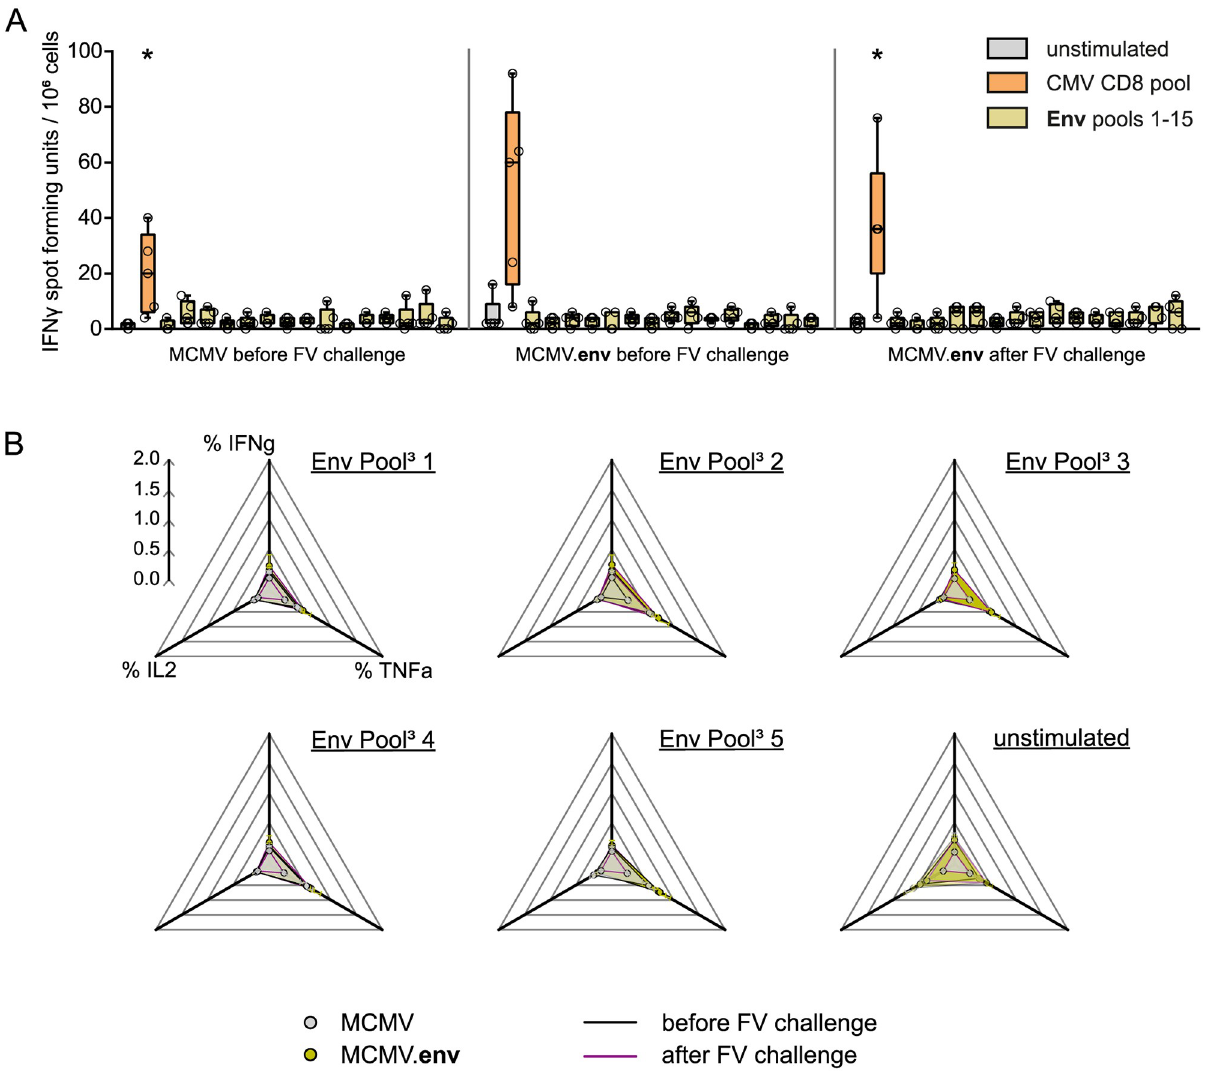
Fig 8. Analysis of Env-reactive T cells. CB6F1 mice were immunized once with MCMV.env, or with a non transgene-encoding MCMV as control, and infected with 5 000 SFFU FV six weeks later. Spleens were collected from mice either five weeks after immunization, or two weeks after FV infection, and restimulated in vitro with Env-derived peptide pools. (A) Spleen cells were depleted of CD4 + cells by magnetic cells sorting, and subjected to restimulation with 15 pools of overlapping peptides spanning the whole Env protein in an ELISpot assay; stimulation with a pool of CMV-derived peptides, or incubation without any peptide stimulation, served as controls. (B) Whole spleen cells were restimulated in vitro with pools of Env-derived peptides, and production of the indicated cytokines was analysed by flow cytometry after intracellular cytokine staining. Data were acquired in one experiment, data shown in (A) are means of two replicates. Each dot indicates an individual mouse (A) or mean values (B). Data were analysed for statistically significant differences by One Way ANOVA on Ranks with Dunn’s post test. � indicates statistically significant differences compared to unstimulated control ( P <